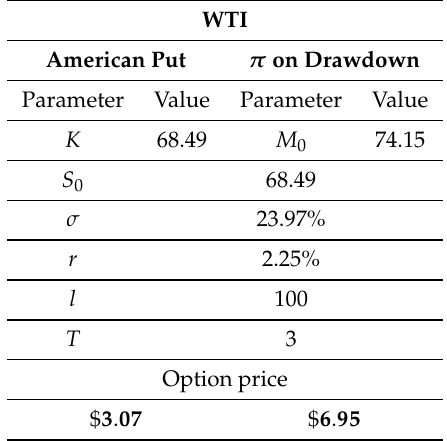
Table 5. Input parameters for computation and estimated options’ prices for the WTI